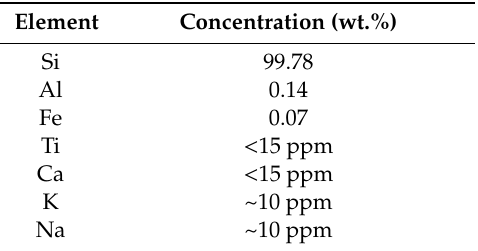
Table 4. Chemical composition of silica powder.